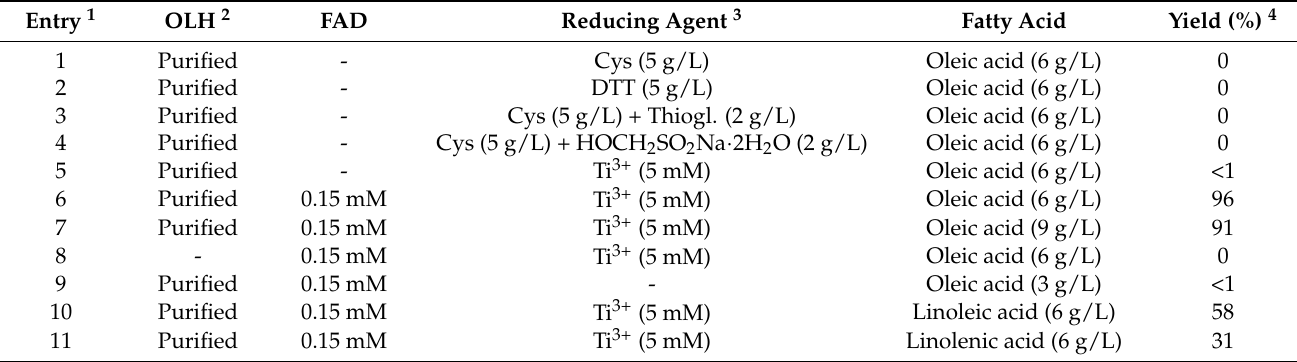
1 Reaction conditions: 10 mL of a reaction mixture containing fatty acid, glycerol (10% v / v ), ethanol (2% v / v ), and potassium phosphate buffer (20 mMol, pH 6.6). The reaction was performed in a sealed tube, previously flushed with nitrogen, at 26 ◦ C for 24 h under shaking. 2 For all trials, the concentration of OLH was set to 0.2 mg/mL. 3 Cys: cysteine, DTT: 1,4-dithiothreitol, Thiogl.: sodium thioglycolate,